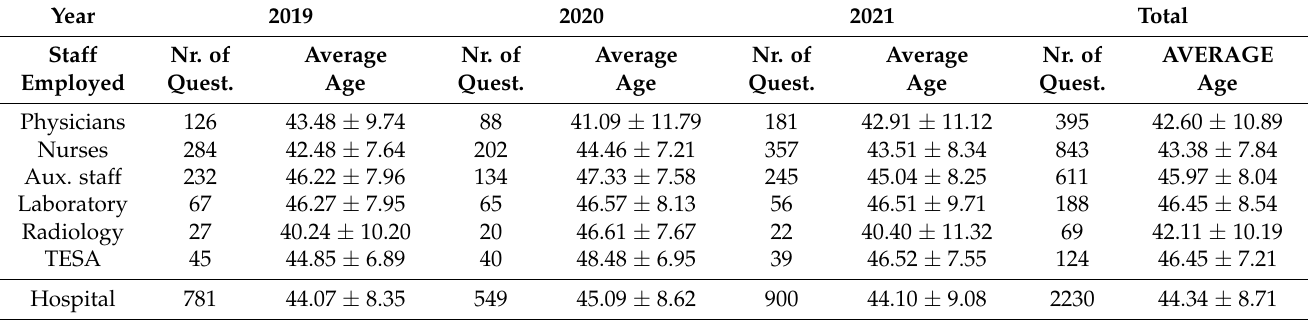
Table 2. Distribution by year and staff group of analyzed questionnaires and average age of